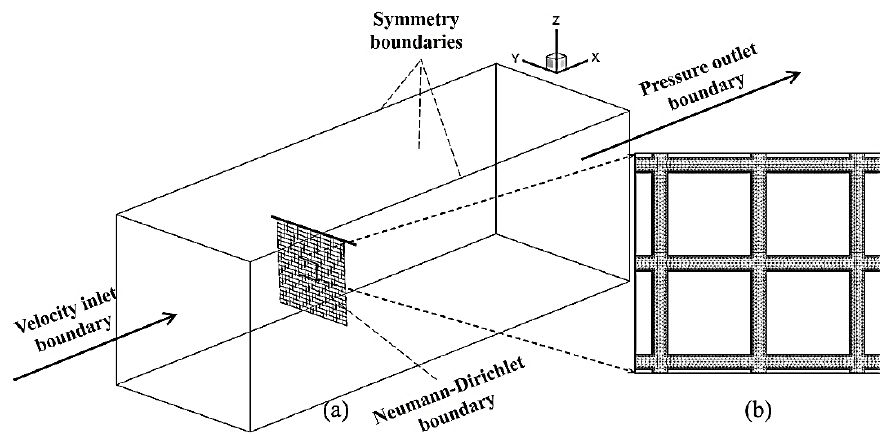
Figure 3. The schematics of the computational domain: ( a ) overall fluid domain and the solid subdomain, and ( b ) grids of the undeformed net panel in the solid subdomain.